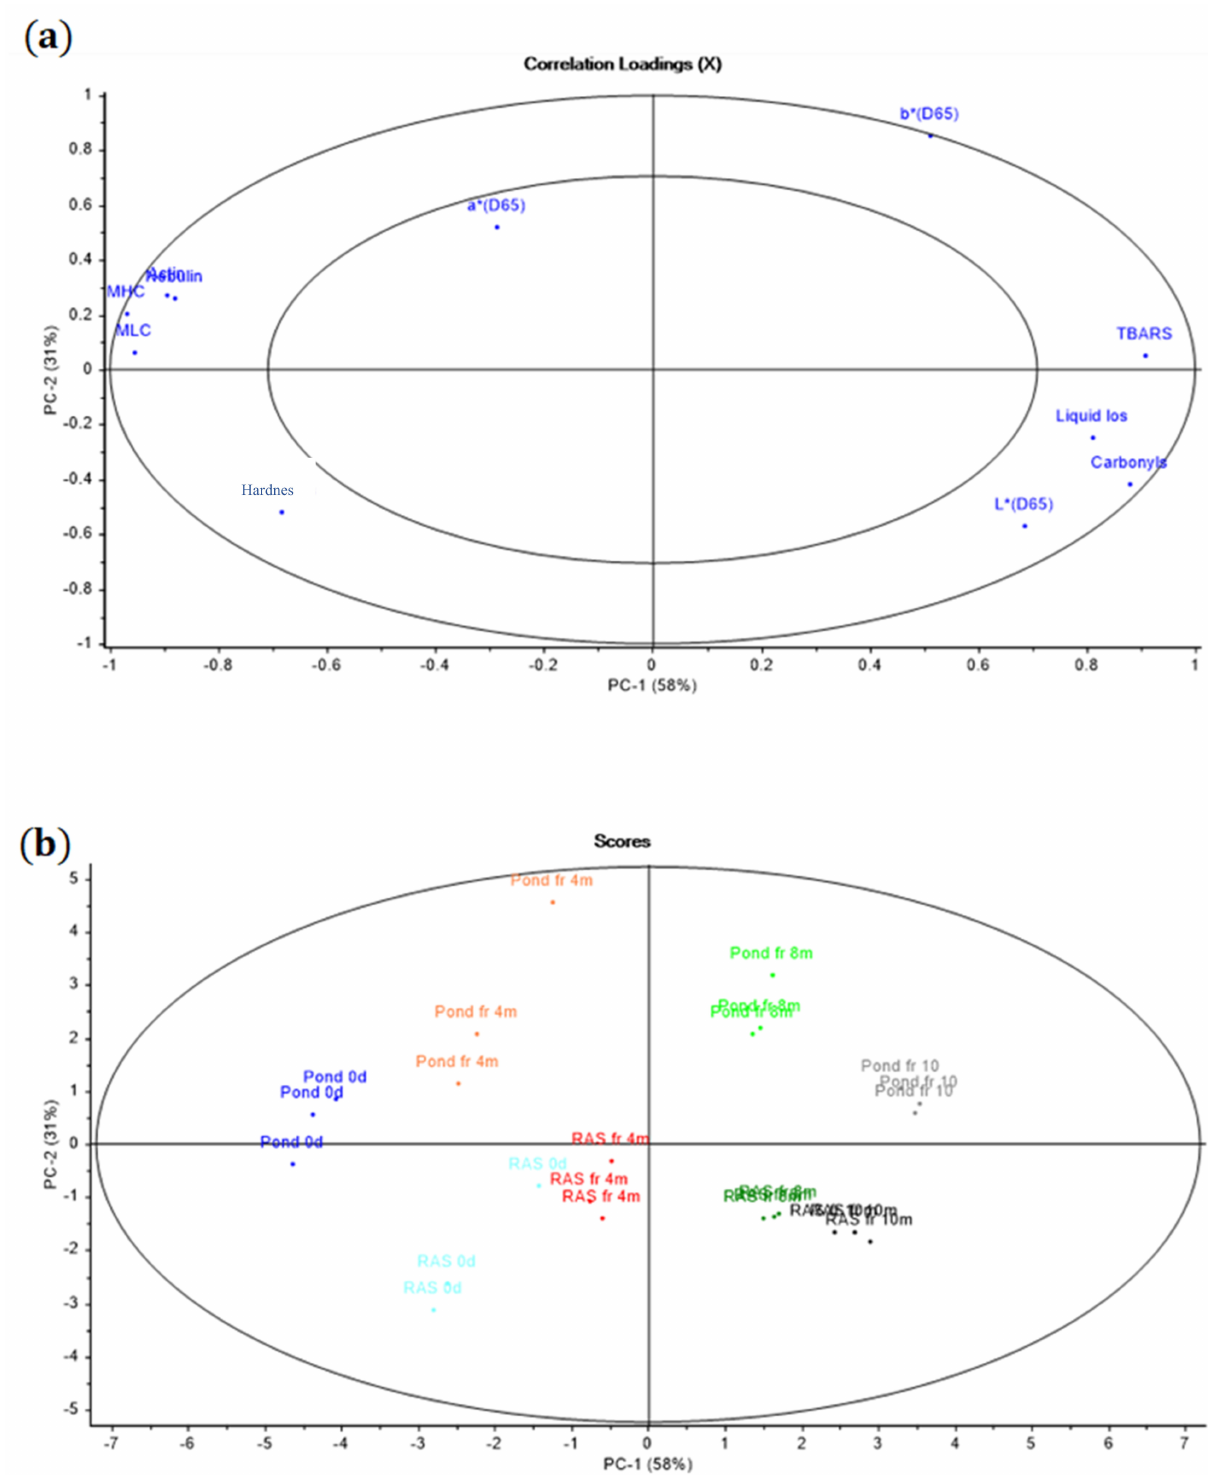
Figure 8. ( a ) PCA plot showing the correlation loadings on PC 1 and PC 2 of the oxidation parameters TBARS and carbonyls, liquid loss, color, specified proteins and hardness parameters of RF and PF during frozen storage. ( b ) PCA plot showing the correlation loadings on PC 1 and PC 2 between the storage time for each rearing